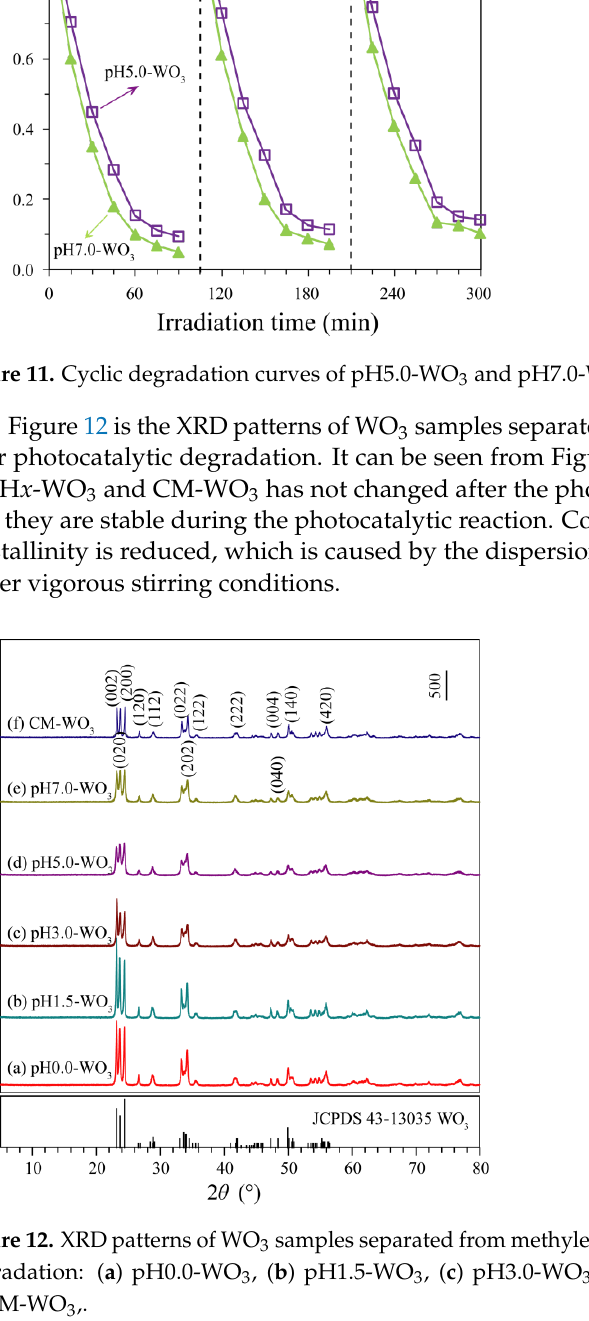
Figure 12. XRD patterns of WO 3 samples separated from methylene blue solution after photocata- lytic degradation: ( a ) pH0.0-WO 3 , ( b ) pH1.5-WO 3 , ( c ) pH3.0-WO 3 , ( d ) pH5.0-WO 3 , ( e ) pH7.0-WO 3 , (f) CM-WO 3 .